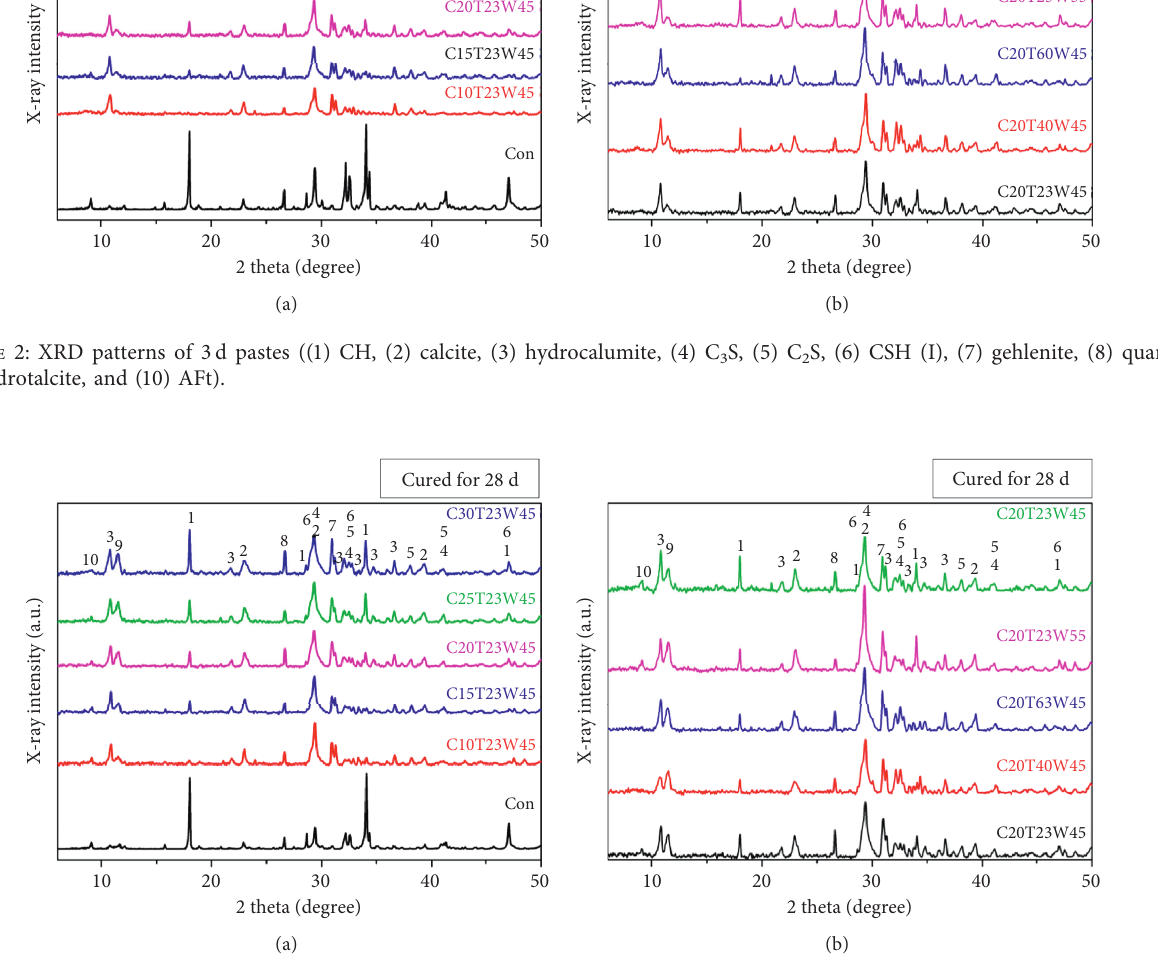
3 S, (5) C 2 S, (6) CSH (I), (7) gehlenite, (8) quartz,